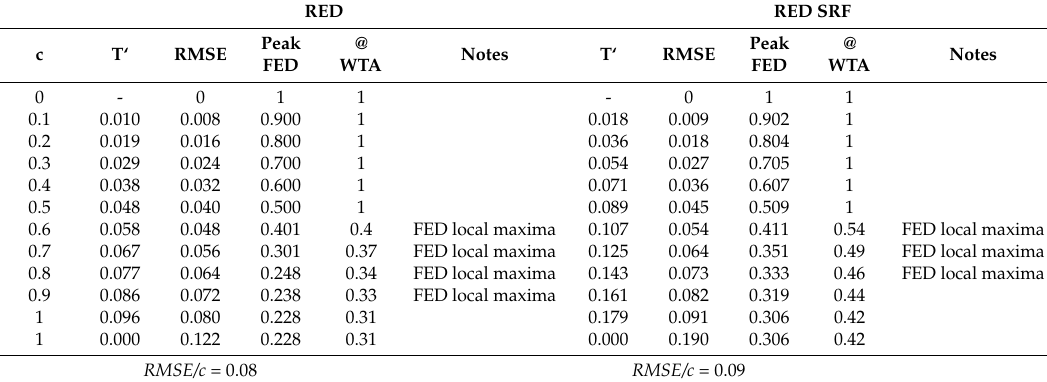
RMSE/c = 0.08 RMSE/c =